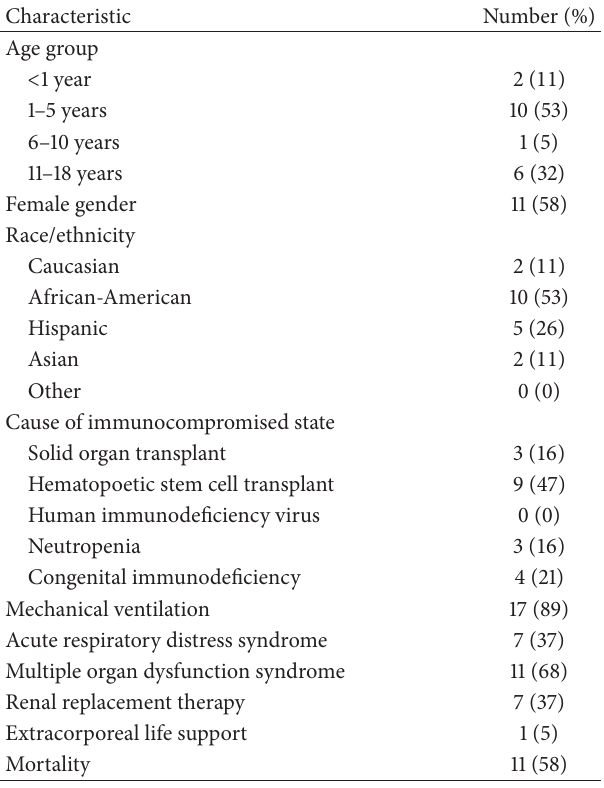
Table 1: Characteristics of immunocompromised patients admitted to the intensive care unit with adenoviral respiratory